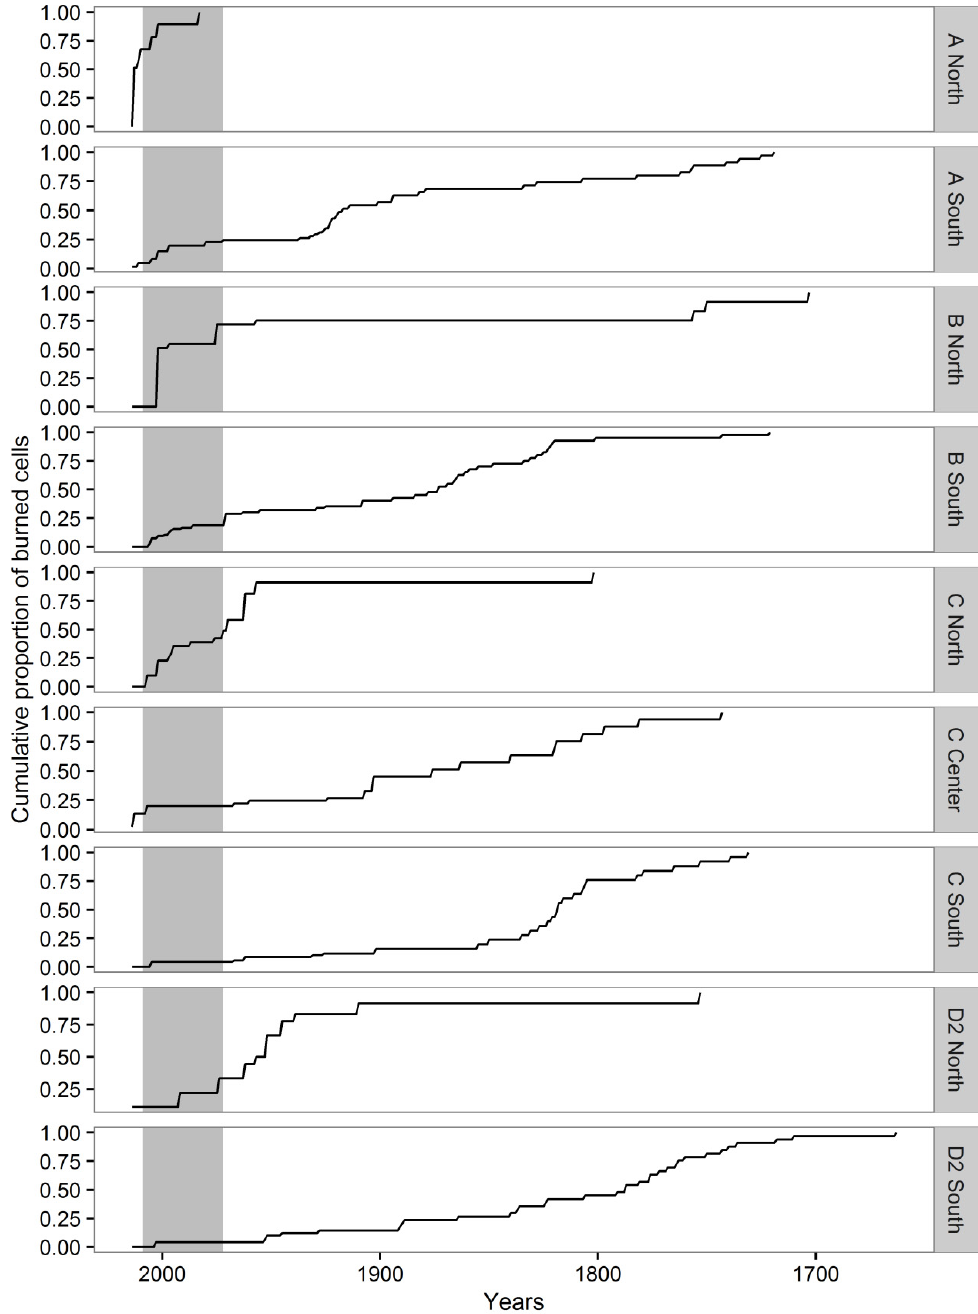
Figure A3. Reverse weighted cumulative proportion of cells that burned per decade in each transect zone. Weights are calculated in the same way that they were in the survival analyses in order to compensate for the over ‐ representation of recent fires (after 1924) in transects. The shaded area shows the 1972–2009 period covered by the fire cycle estimates calculated by Gauthier et al. [24]. Table A1. Mean relative fire risk of transect zones compared to mean risk of the transect with 95% bootstrap confidence intervals (CI95) (e.g., zone north of transect A has a risk 15.61 times higher than the mean risk of the transect, while zone south of the same transect has a risk 3.33 times lower or equals to 0.30 times the mean risk of the transect). Relative fire risk values take into account the down ‐ weighting of recently burned cells.